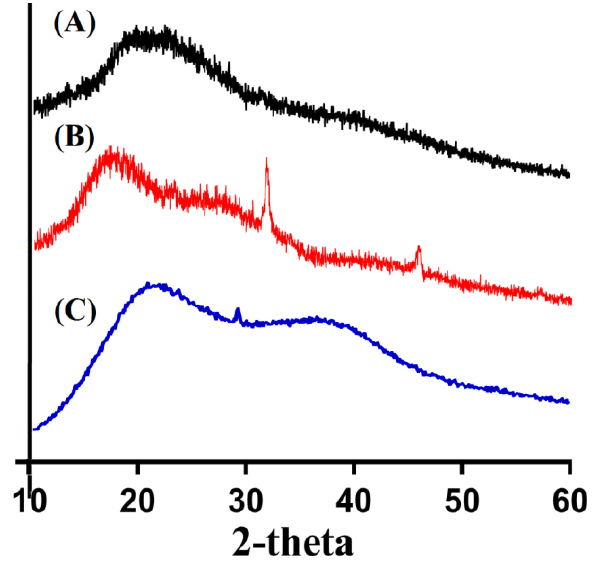
Figure 8. PXRD of ( A ) Cs, ( B ) Sps, and ( C ) Cs/SpsCpAca hydrogel.